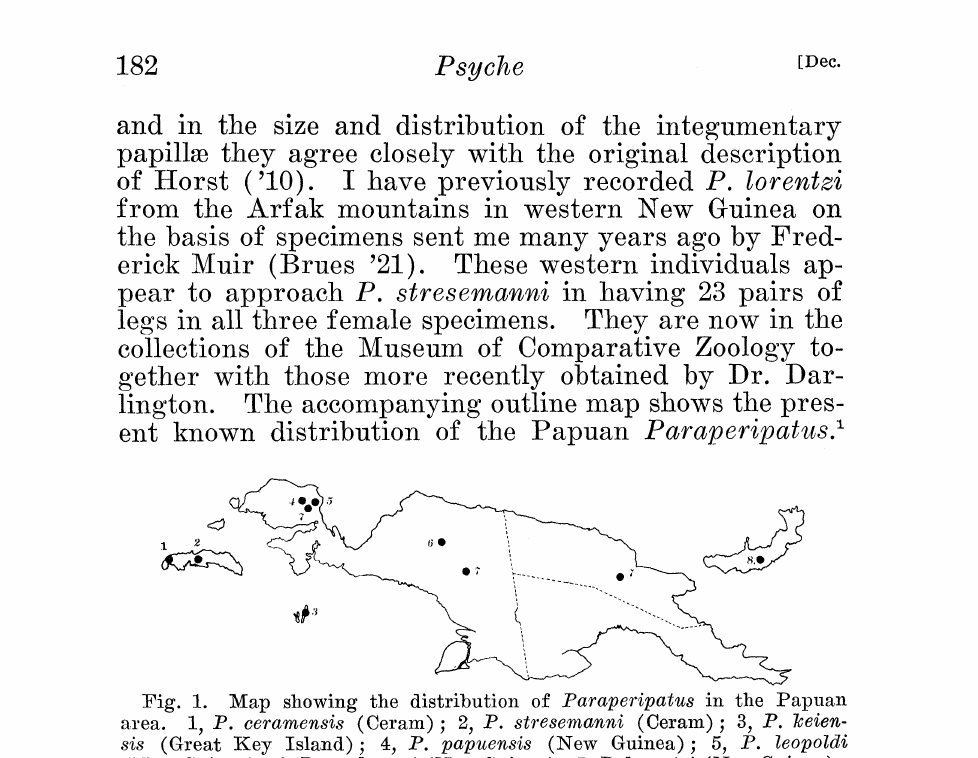
Fig. 1. Map showing the distribution of Paraperipatus in the Papuan area. 1, P. ceramensis (Ceram); 2, P. stresemanni (Ceram); 3, P. leien- sis (Great Key Island); 4, P. papuensis (New Guinea); 5, P. leopoldi (New Guinea) 6, P. vanheurni (New Guinea) 7, P. lorentzi (New Guinea) 8, P. novce-britannic (New